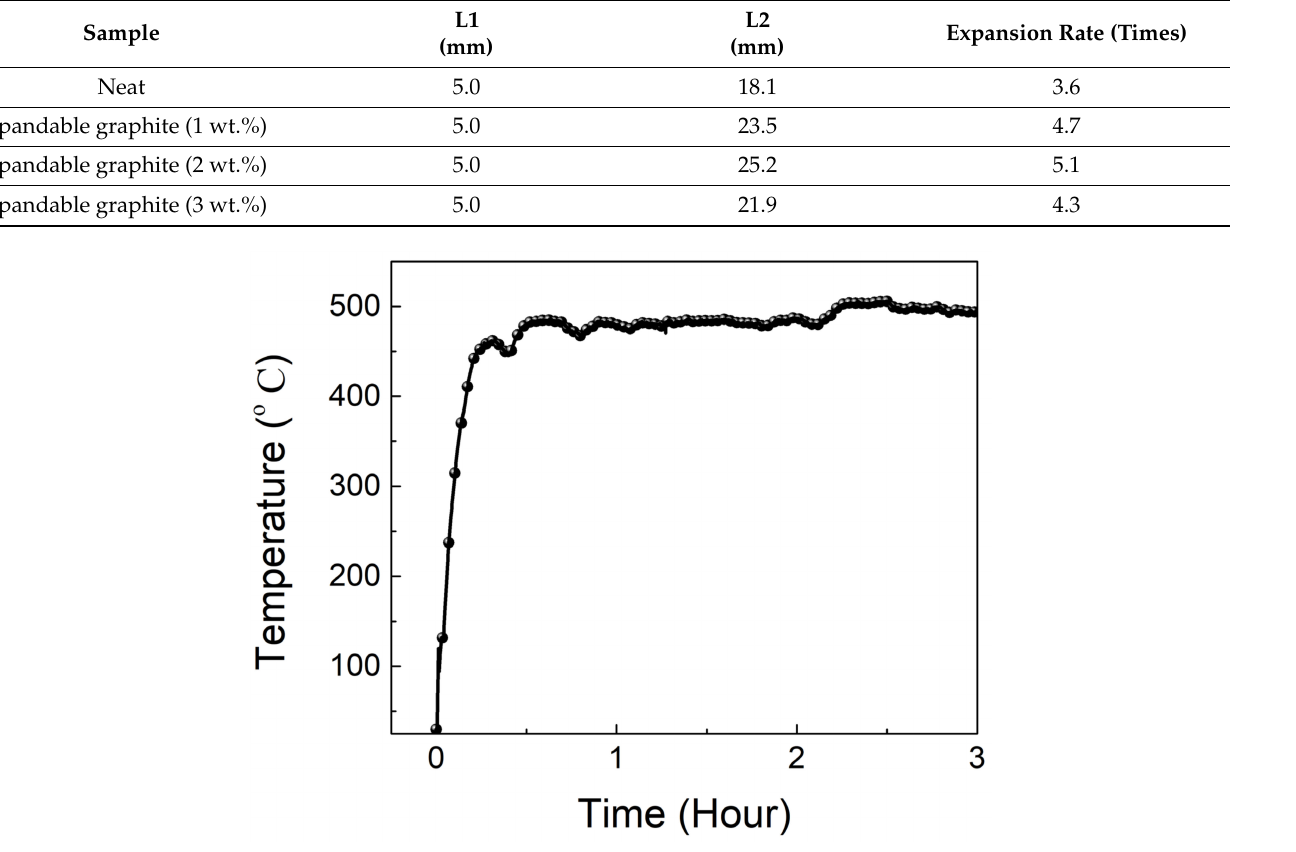
Figure 13. Back surface temperature vs. time of the three-hour flame testing for intumescent flame- resistance coating with the obtained optimal